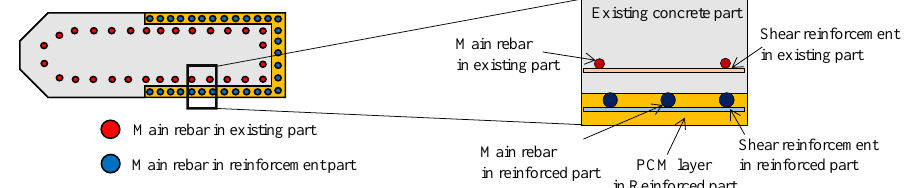
Figure 13. Modeling of the reinforcement part. The PCM cover was 69 mm, and the main reinforcing bar diameter was D25 with a spacing of 250 mm for both